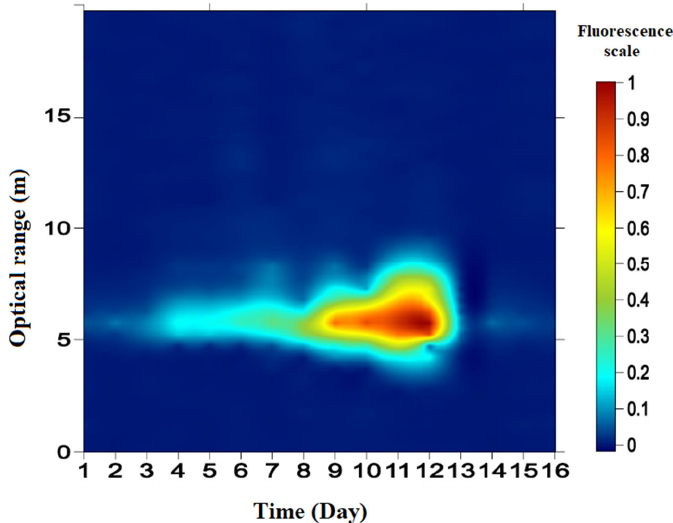
Figure 3. Time–range intensity profile of C. reinhardtii during the 16 ‐ day sampling period.